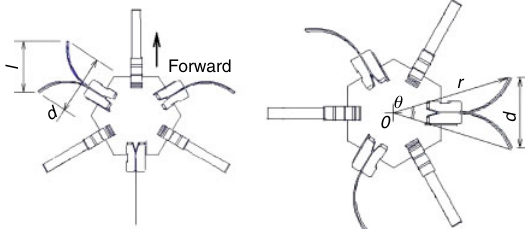
Figure 15 Left: The efficiency of the driver in walking motion. Right: The efficiency of the driver in rotating motion.